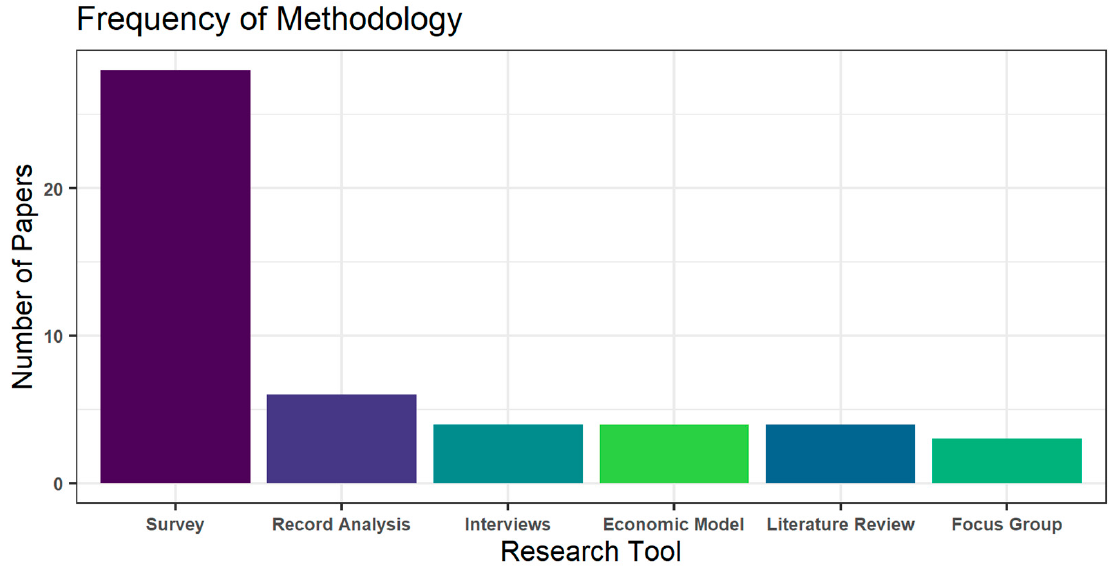
Figure 1. The frequency with which various research tools have been employed in the investigation of social perceptions of prescribed fire in the US Great Plains. There are more than 44 observations recorded in this figure, as some articles employed multiple research